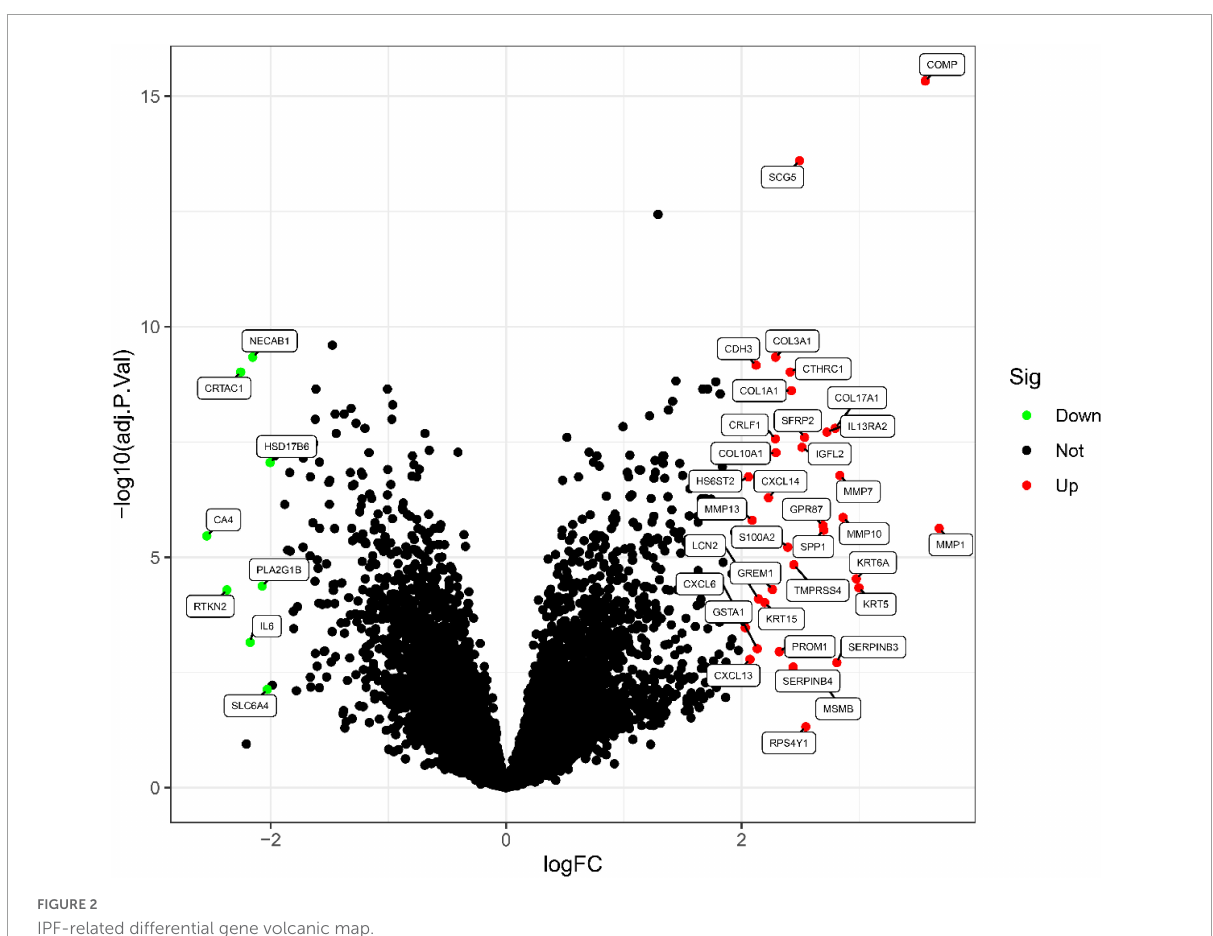
FIGURE2 IPF-related differential gene volcanic